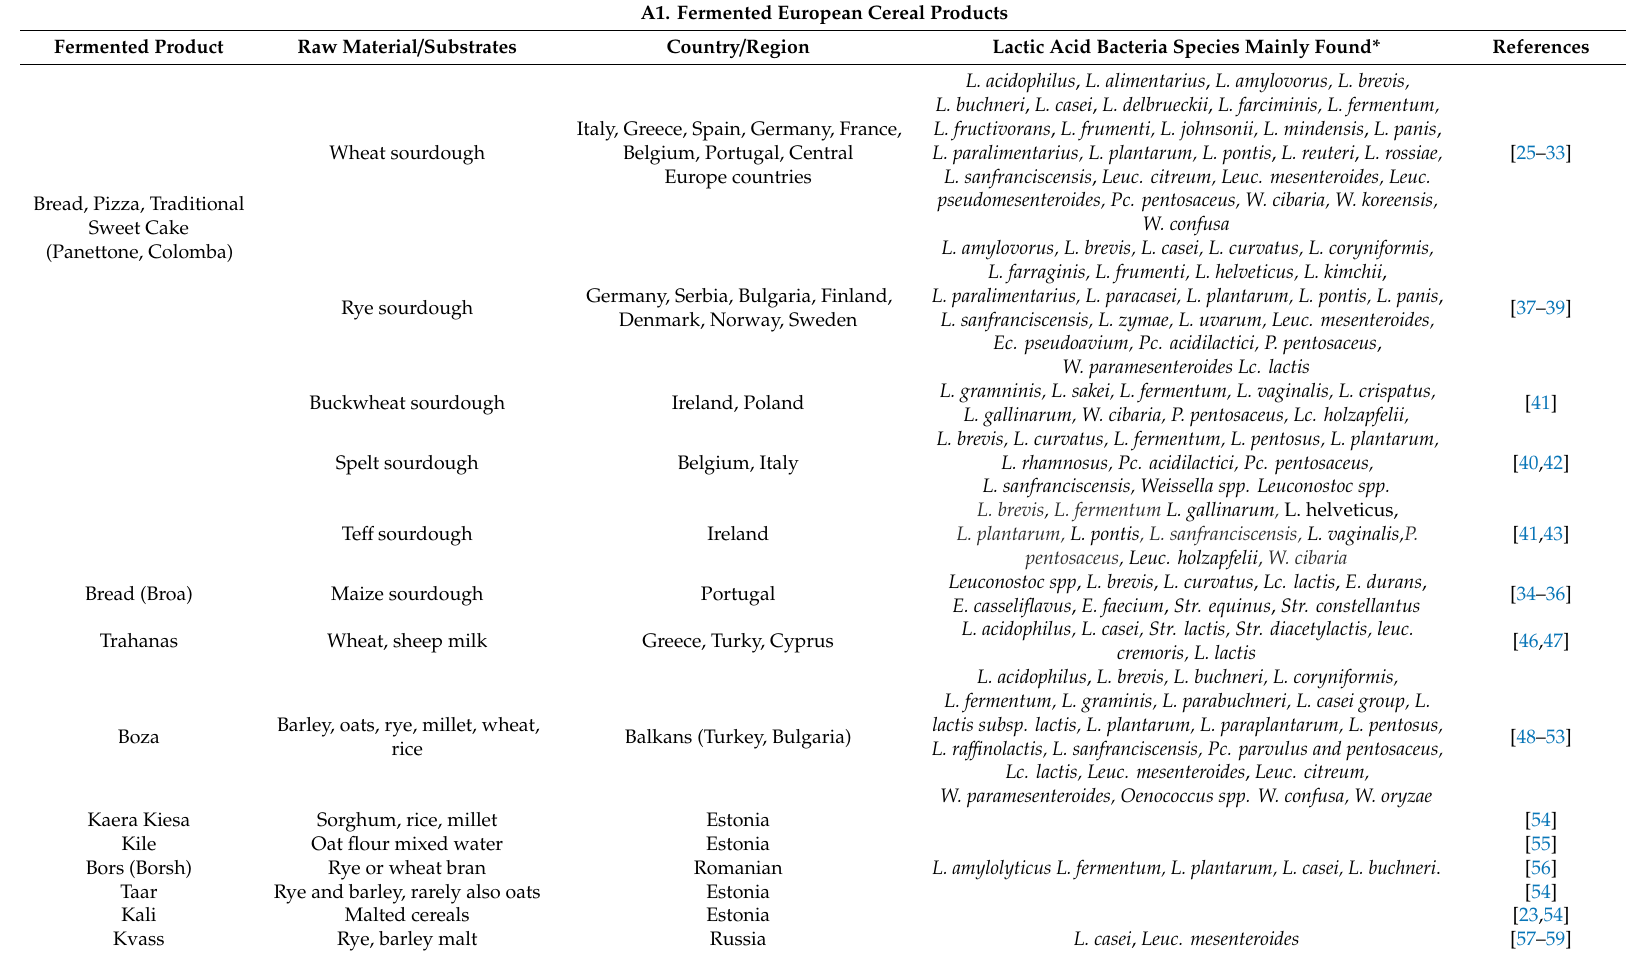
Table 1. Selected lactic acid bacteria fermented cereals and vegetables in